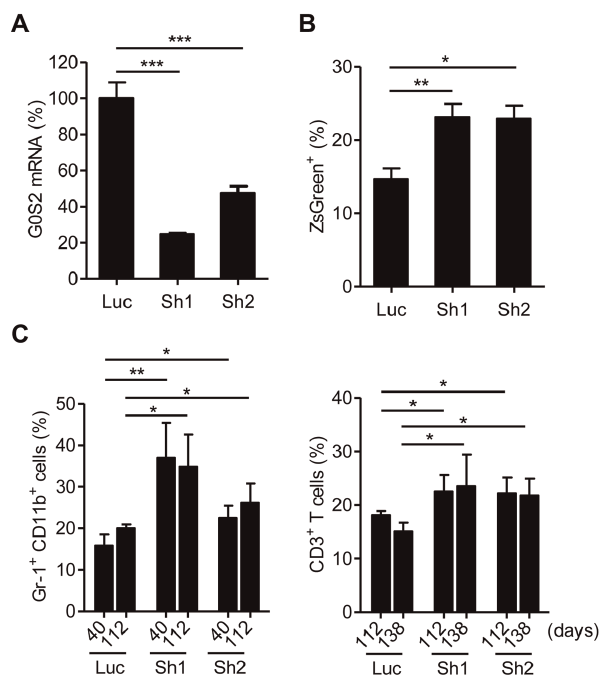
Figure 3. Silencing of endogenous G0S2 expression in BM cells increases blood chimerism upon transplantation. Expression of the endogenous G0S2 gene was silenced in BM cells using two G0S2- specific pSIREN-shRNA retroviruses (Sh1, Sh2). Luciferase pSIREN-shRNA (Luc) was used as a control. (A) Knockdown efficiency was determined by quantitative real-time PCR in transduced BM cells ( n =4). (B) Sixteen weeks after transplantation, blood chimerism was measured by flow cytometry ( n =3–4). (C) The contribution of donor-derived cells to the Gr-1 + CD11b + and CD3 + T cell populations was analyzed at different times after the transplant ( n =3–4). *, P , 0.05, **, P , 0.01, and ***, P , 0.001 (two-tailed Student’s t -test).